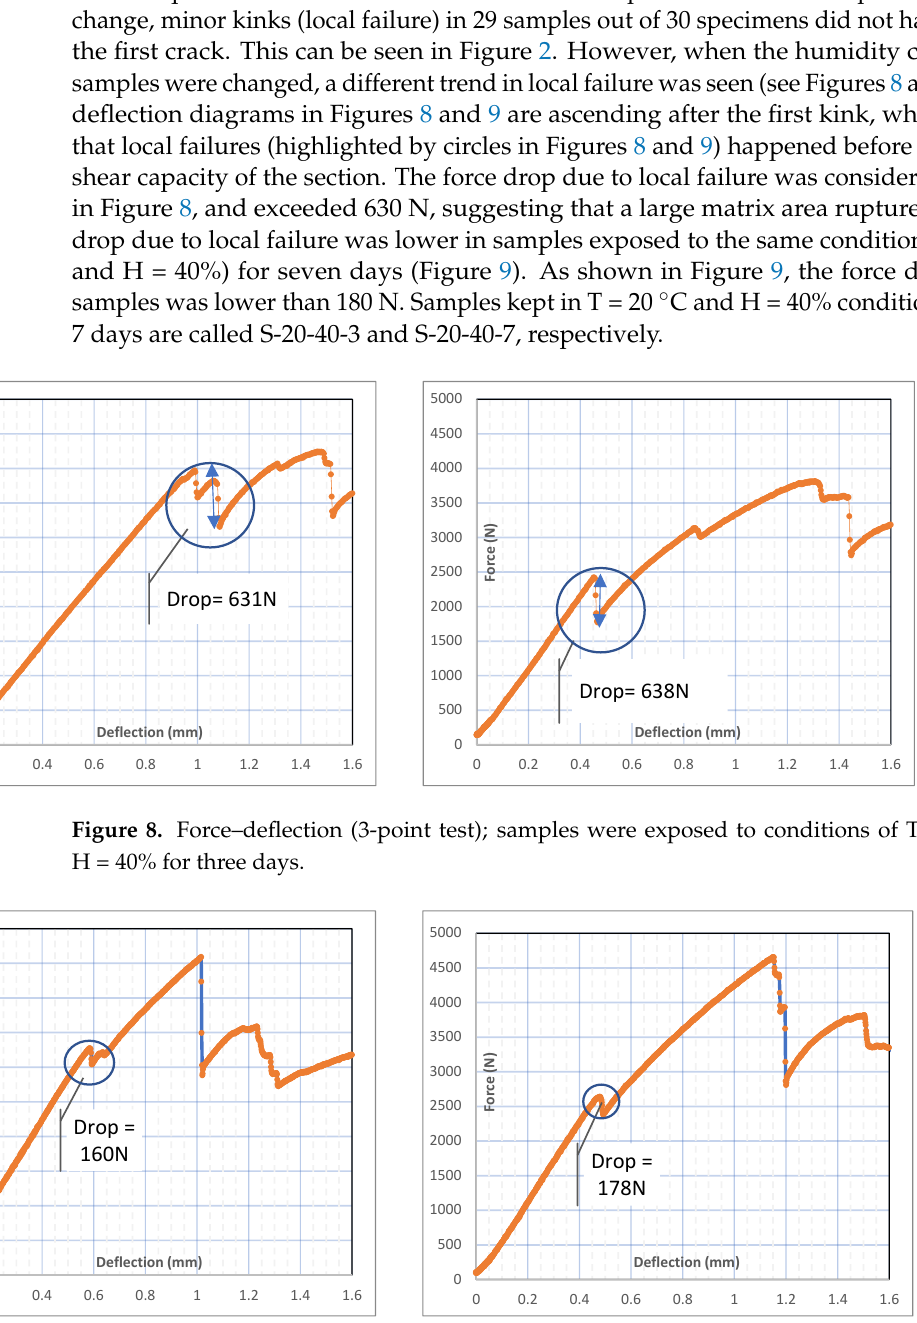
Figure 9. Force–deflection (3-point test); samples were exposed to the conditions of T = 20 °C and H = 40% for seven days.